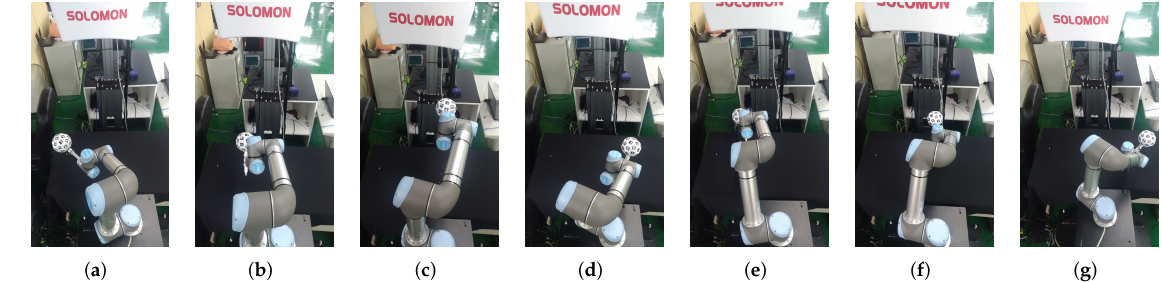
Figure 10. Vision-robot calibration leveraging Solpen. ( a – g ) The UR robot with Solpen attached as its TCP is moved to seven points to collect calibration information.